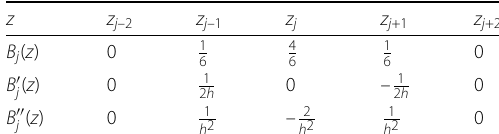
Table 1 The Coefficients of cubic B-splines and their derivatives at knots z j